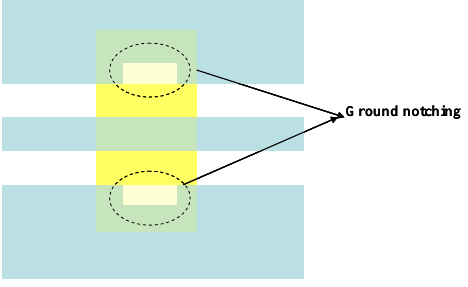
Figure 9: Layout of RF-switch with notched CPWground